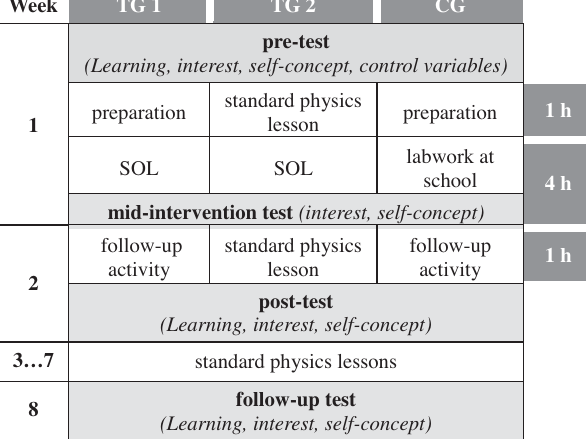
FIG. 3. Study design. The comparison between TG1 and TG2 is about a lab work unit with and without integration (Hyp1a, Hyp2a) and the comparison between TG1 and CG is about a lab work unit at a SOL and at school (Hyp1b,